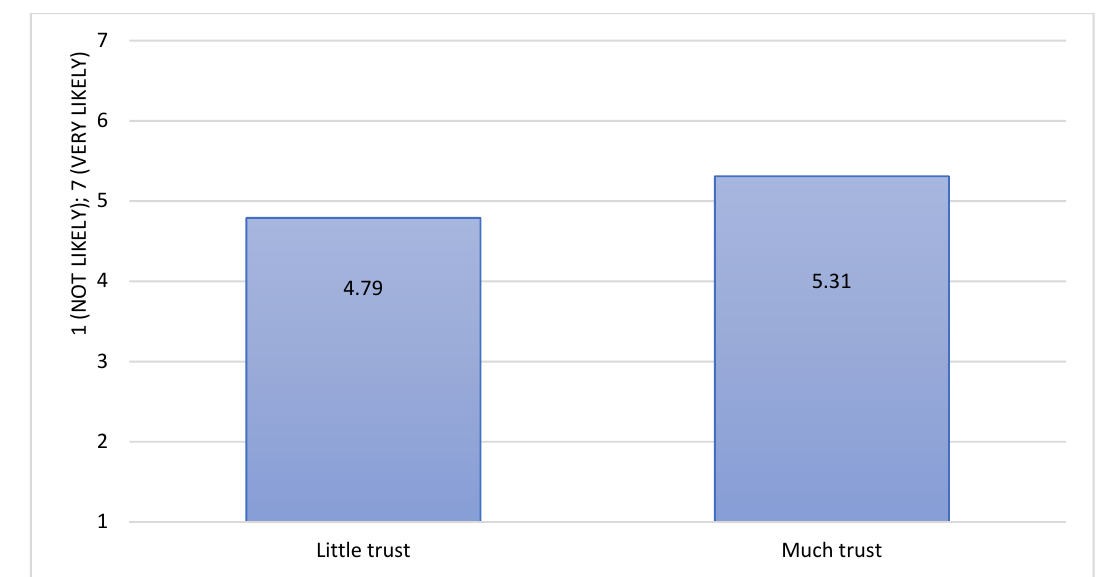
Figure 11. Probability of adopting agroecological practices in the future based on farmers’ experience with agroecological practices.